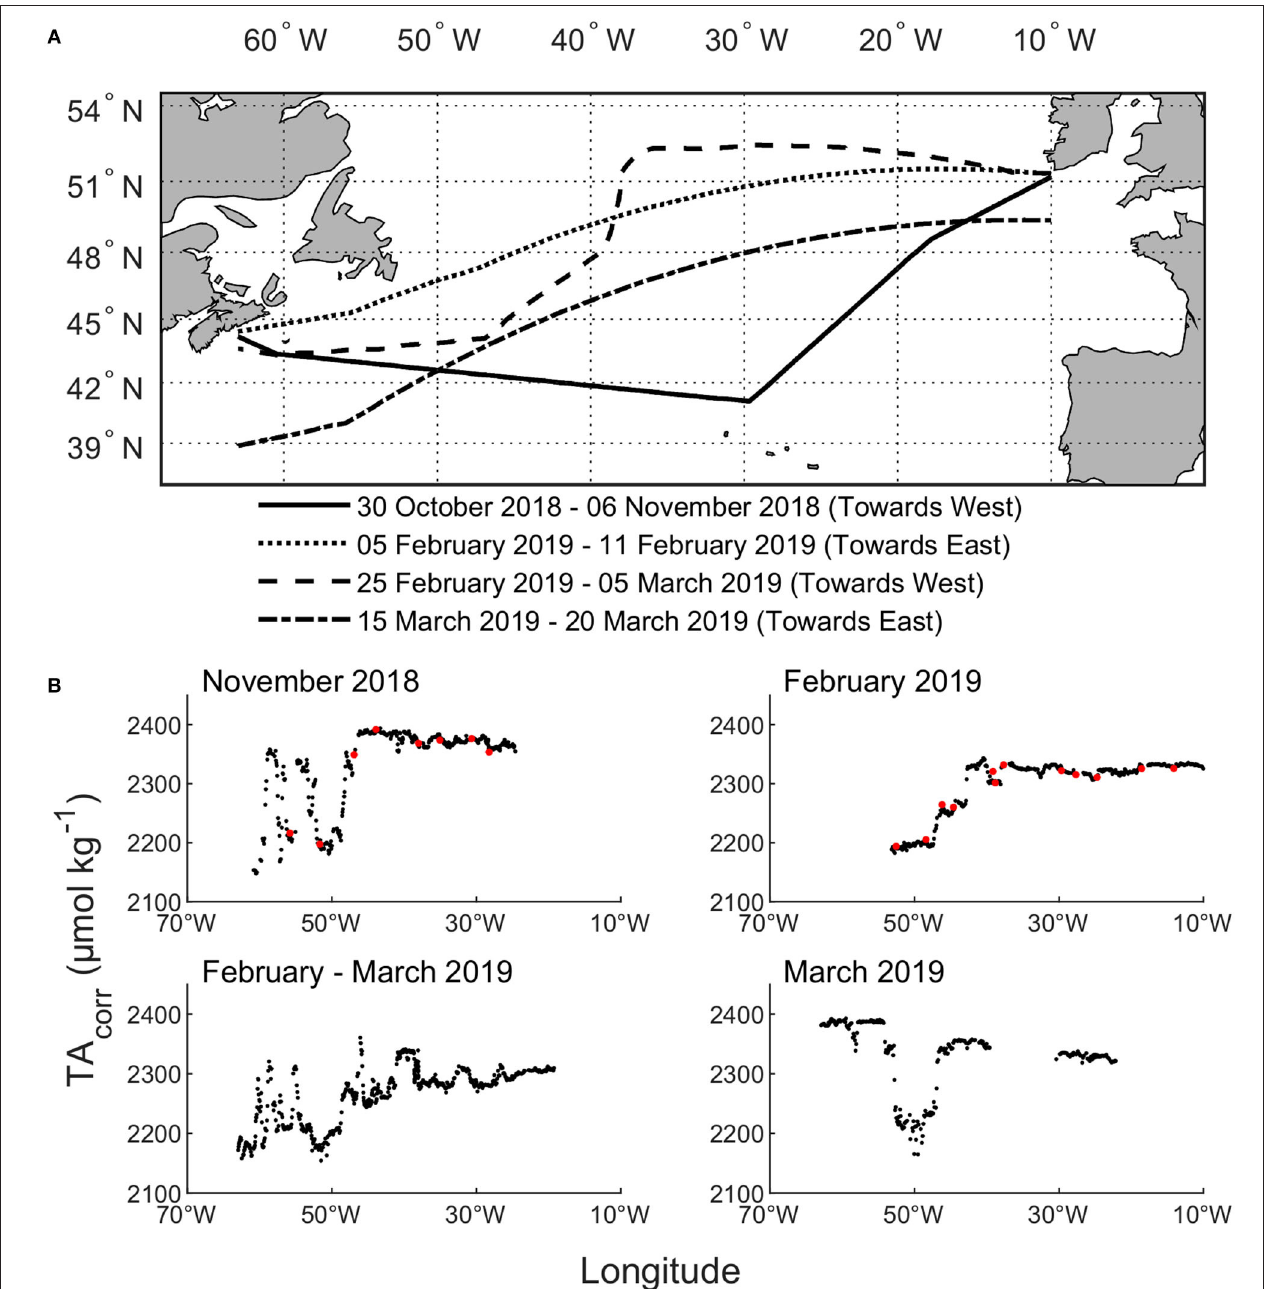
FIGURE 6 | (A) Cruise tracks of the first four campaigns on the North Atlantic SOOP line. (B) TA values corrected for instrument drift during the first four measuring campaigns as a function of the measured longitudes. Each filled red circle represents the TA value of a discrete sample taken at a certain time. Both plots on the left are from westward crossings, and both plots on the right are from eastward